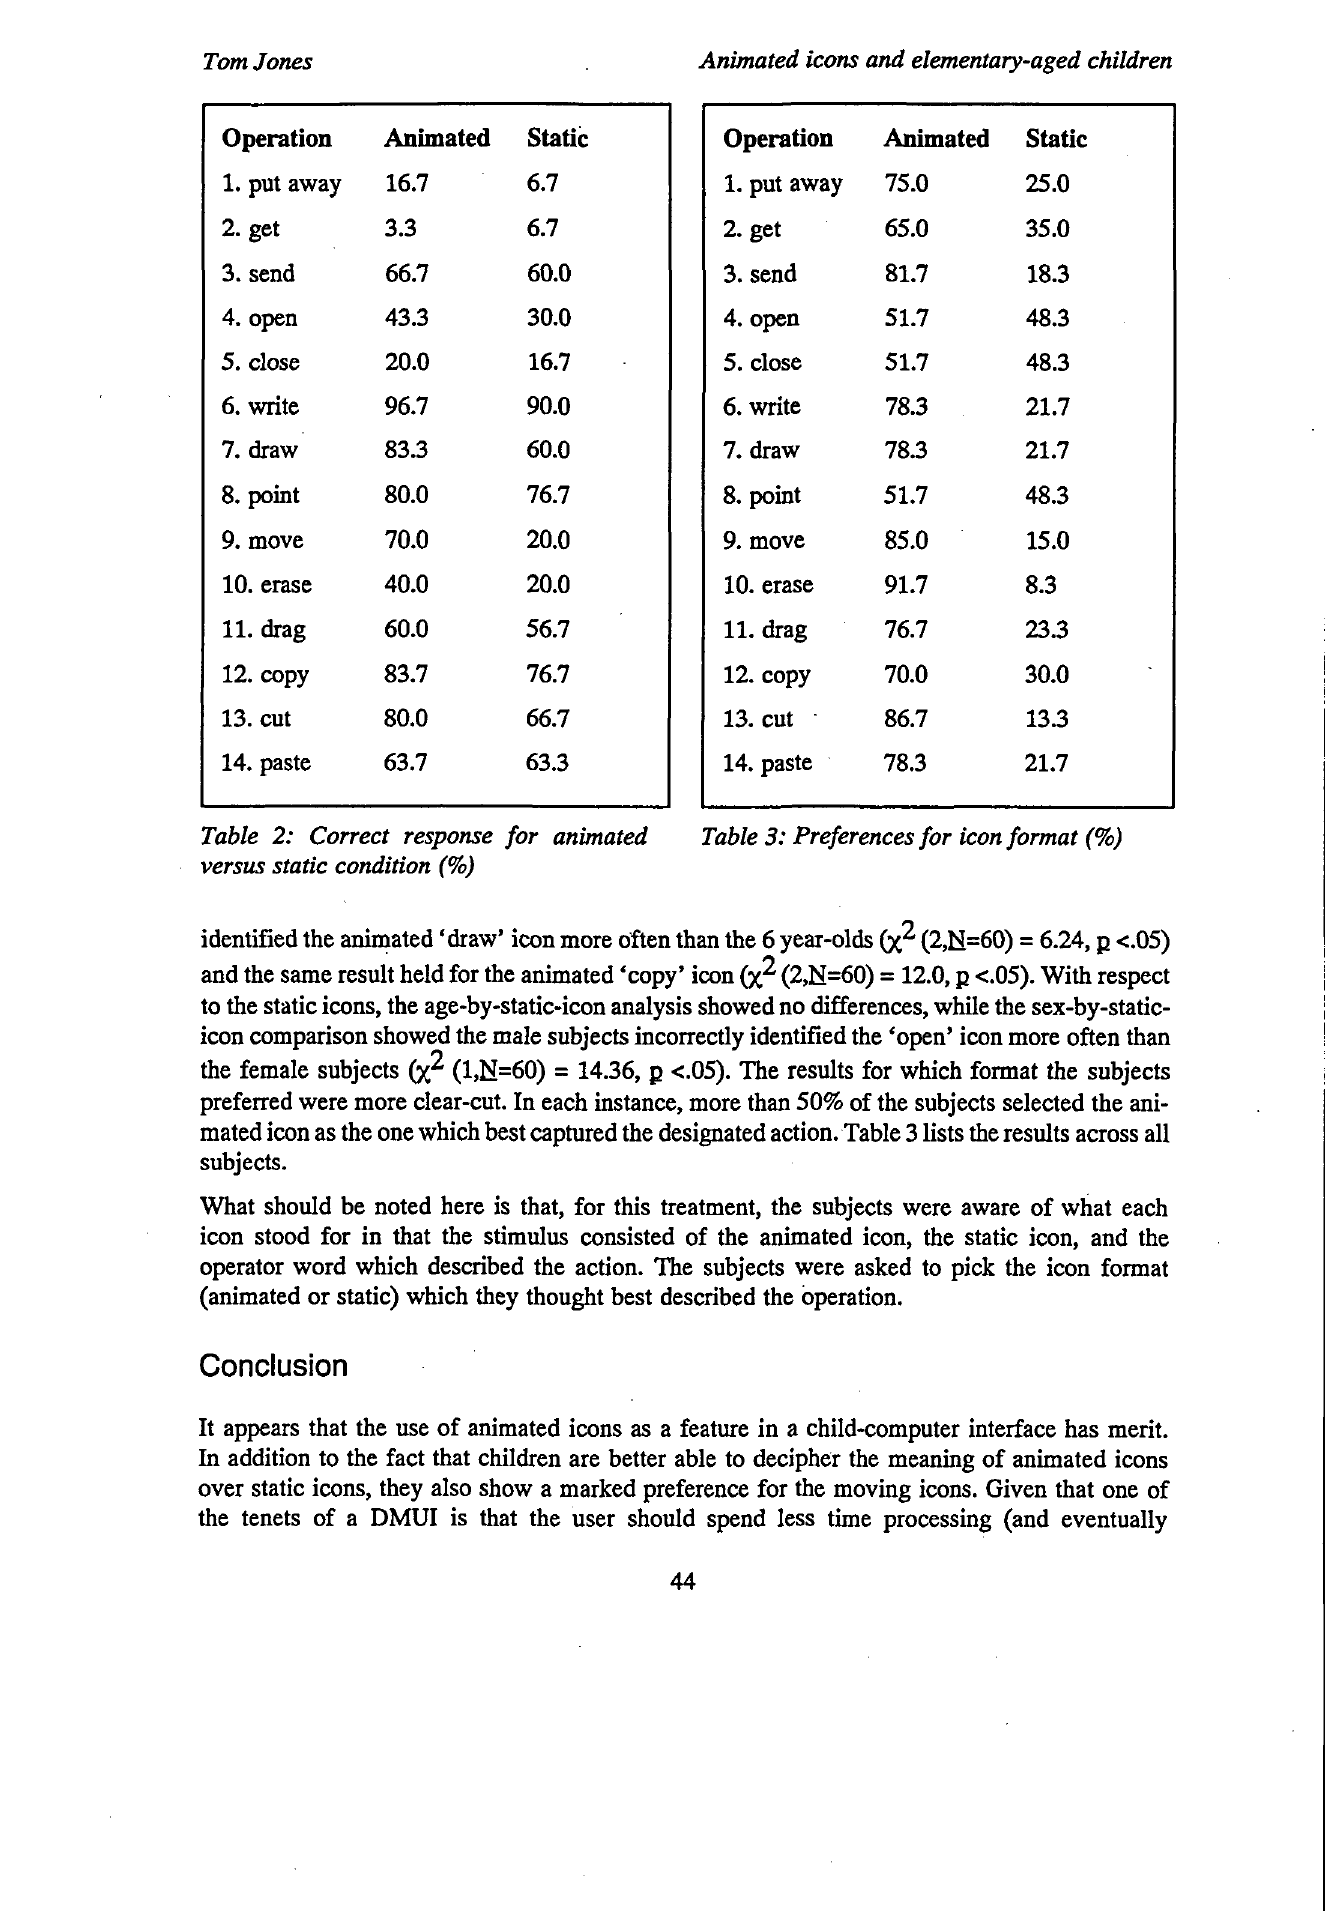
Table 3: Preferences for icon format